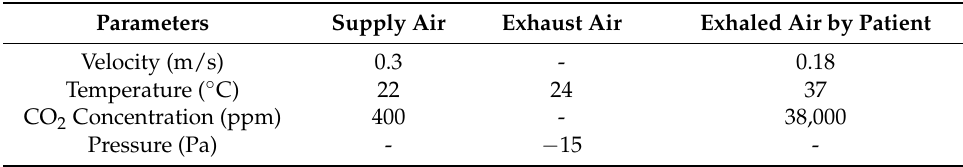
Table 1. Boundary conditions for numerical simulation.